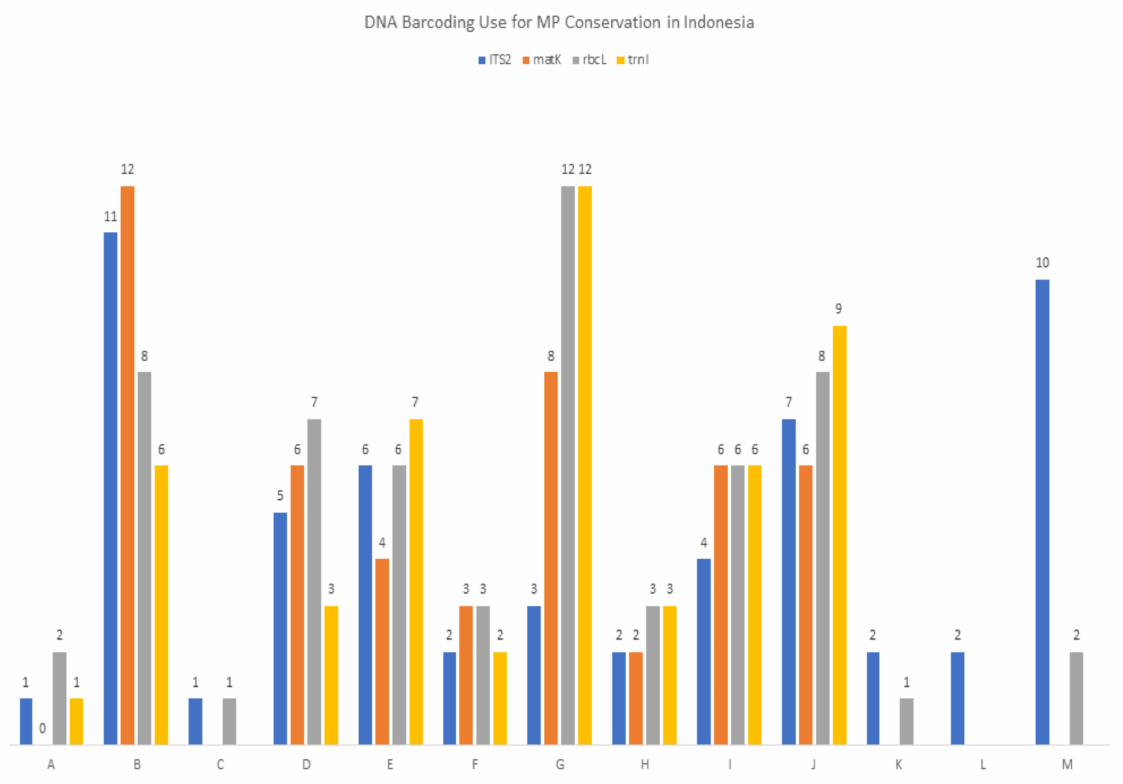
Figure 1. Summary of DNA barcoding use for medicinal plant (MP) conservation in Indonesia. Letters represent the DNA barcoding contribution of a species to the DNA bank data and its importance in conservation in the following order; A = new DNA barcoding and can strongly assist MP conservation; B = can strongly assist MP conservation; C = new DNA barcoding and can assist MP conservation; D = can assist MP conservation; E = new DNA bank data and new DNA barcoding and may strongly assist MP conservation; F = new DNA barcoding and may strongly assist MP conservation; G = may strongly assist MP conservation; H = new DNA bank data and new DNA barcoding and may assist MP conservation; I = new DNA barcoding and may assist MP conservation; J = may assist MP conservation; K = new DNA bank data and new DNA barcoding but sequences need to be clarified further; L = new DNA barcoding, but sequences need to be clarified further; M = sequences need to be clarified further.